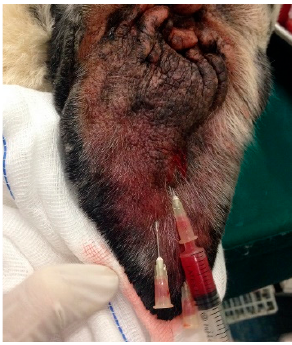
Figure 2. L-PRP application after